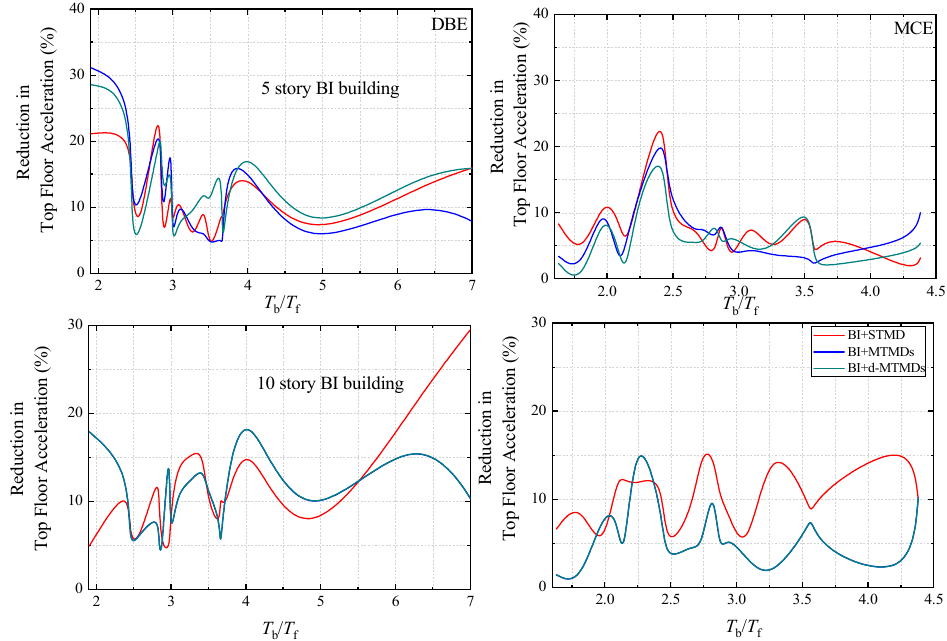
Figure 6. Reduction in average of peak top floor acceleration of BI and BI equipped by TMD schemes under DBE earthquake ground motions.